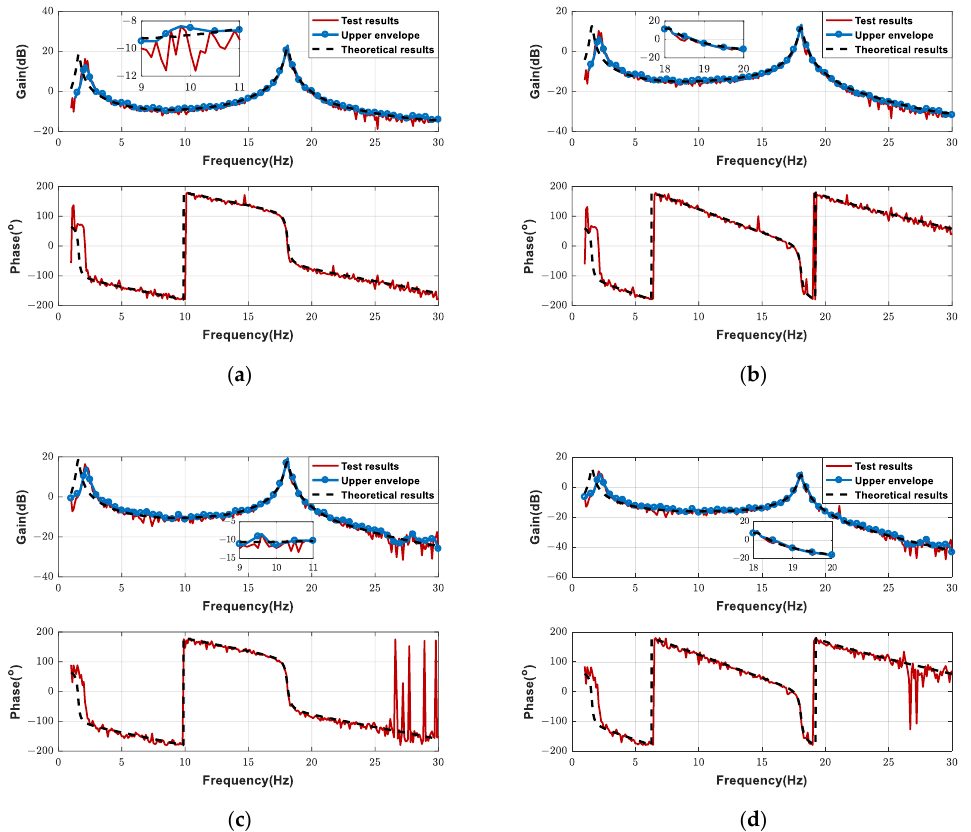
Figure 24. Comparison of ASE open-loop FRF for the four states at Ma = 1.5. ( a ) U1C1 state. ( b ) U1C2 state. ( c ) U2C1 state. ( d ) U2C2 state. state. ( c ) U2C1 state. ( d ) U2C2